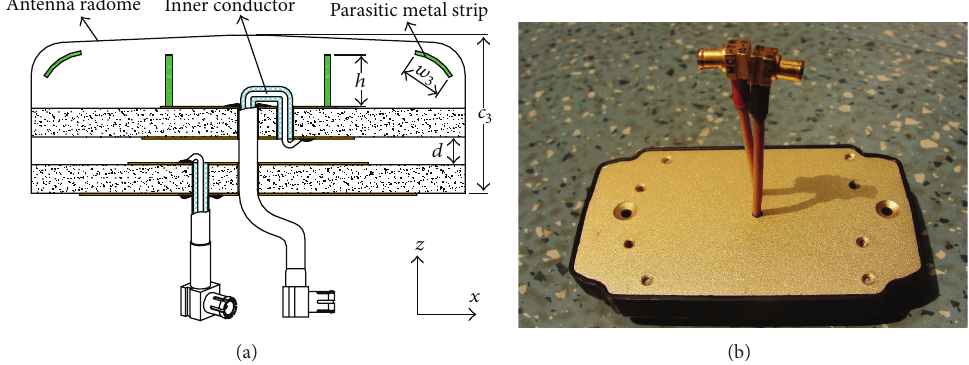
Figure 3: (a) Geometry of the proposed antenna, (b) photograph of the fabricated antenna.